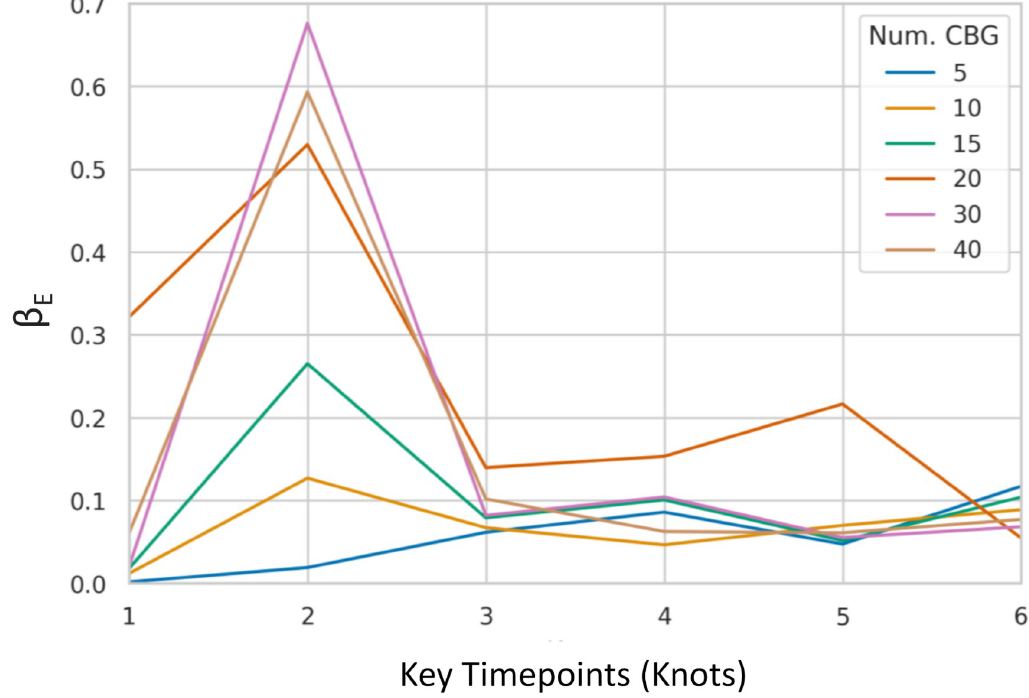
Fig 14. Posterior mean parameter values with varying network size. We vary the size of our simulated network by varying the number of Census Block Groups (CBG) used during construction. We observe that the inferred disease parameters follow a similar trend even across large differences in network